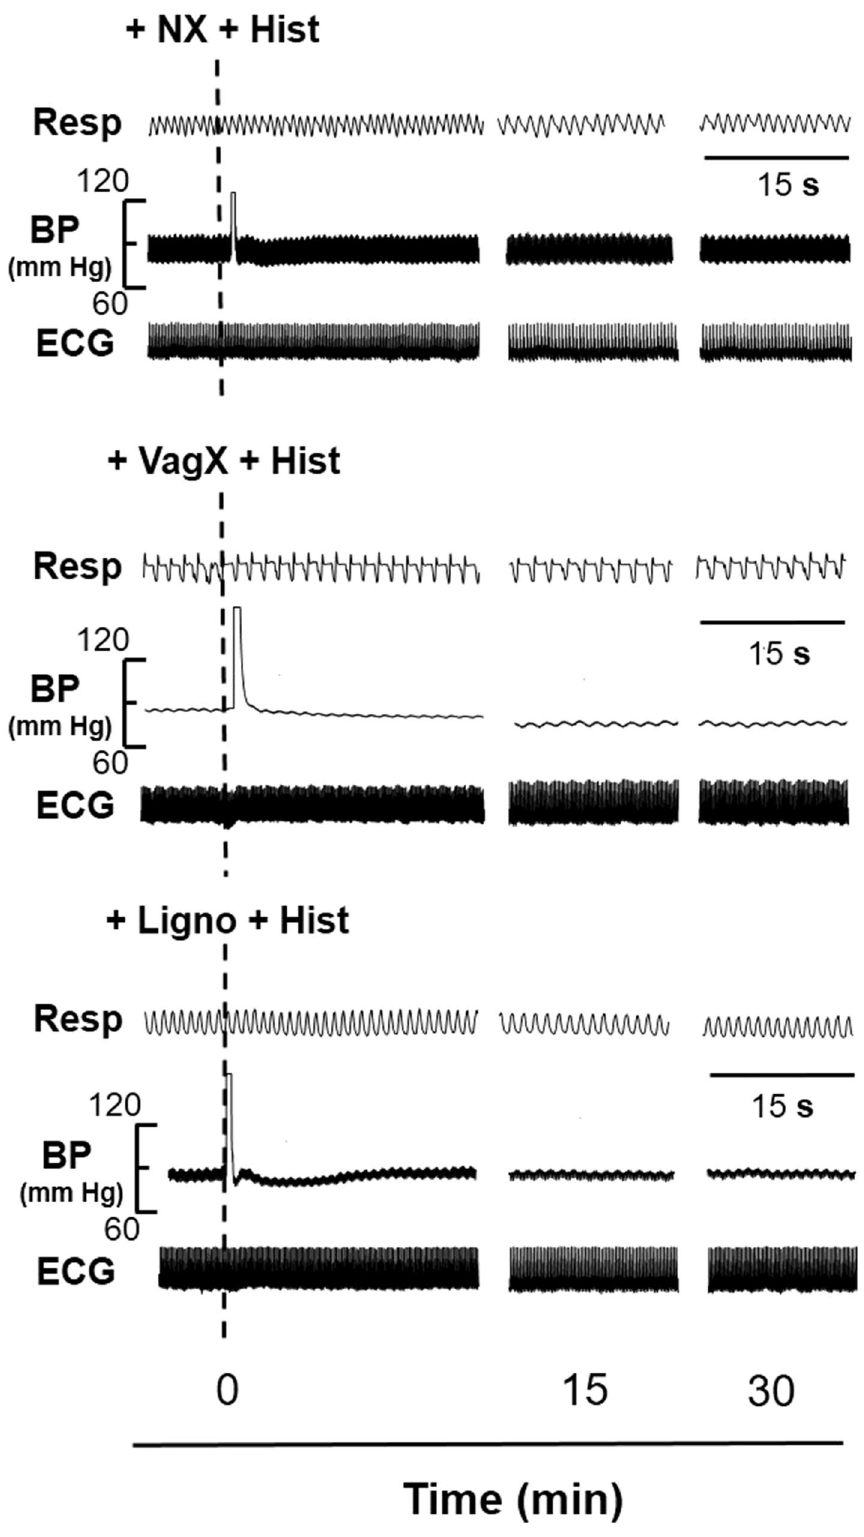
Figure 4. Representative prototypes of original recordings showing the effects of 10 mM histamine (Hist) on respiration (Resp), blood pressure (BP) and electrocardiogram (ECG), after ipsilateral sciatic and femoral neurotomy (+NX), bilateral vagotomy (+VagX) and pre-treatment with lignocaine (+Ligno). The responses are shown at different time intervals as indicated in the lower panel. The points of instillation of Hist after interventions are shown by dotted lines. The horizontal line in each panel is 15 s for all